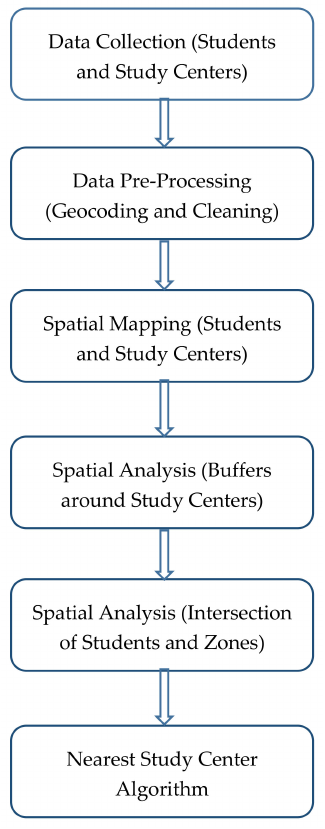
Figure 1. Detailed flowchart of